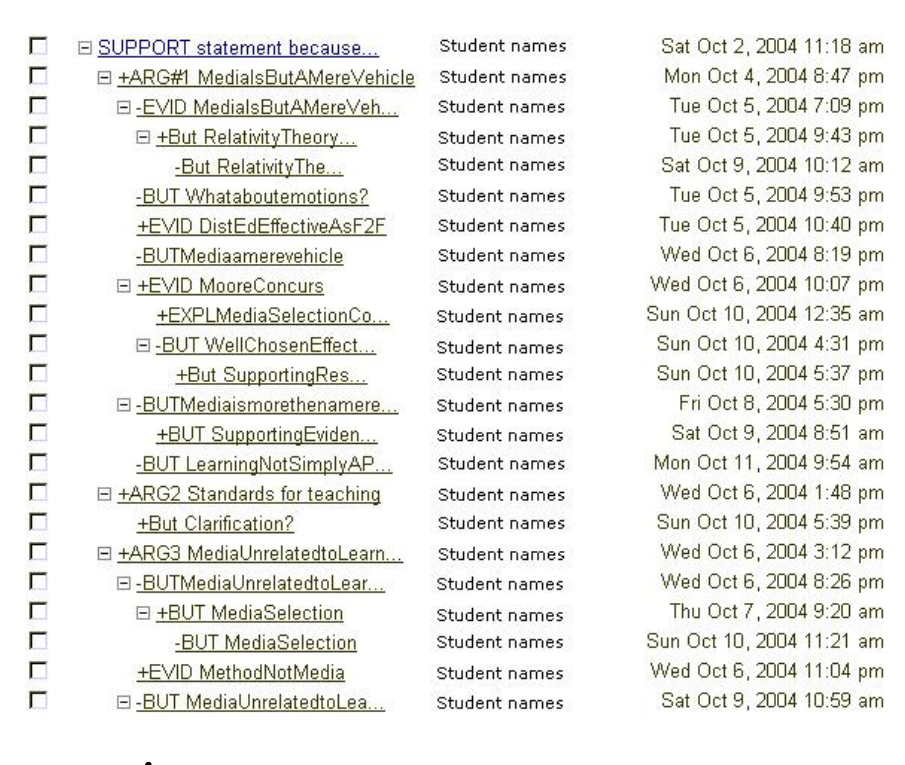
Figure 2. Example of online debate with labeled